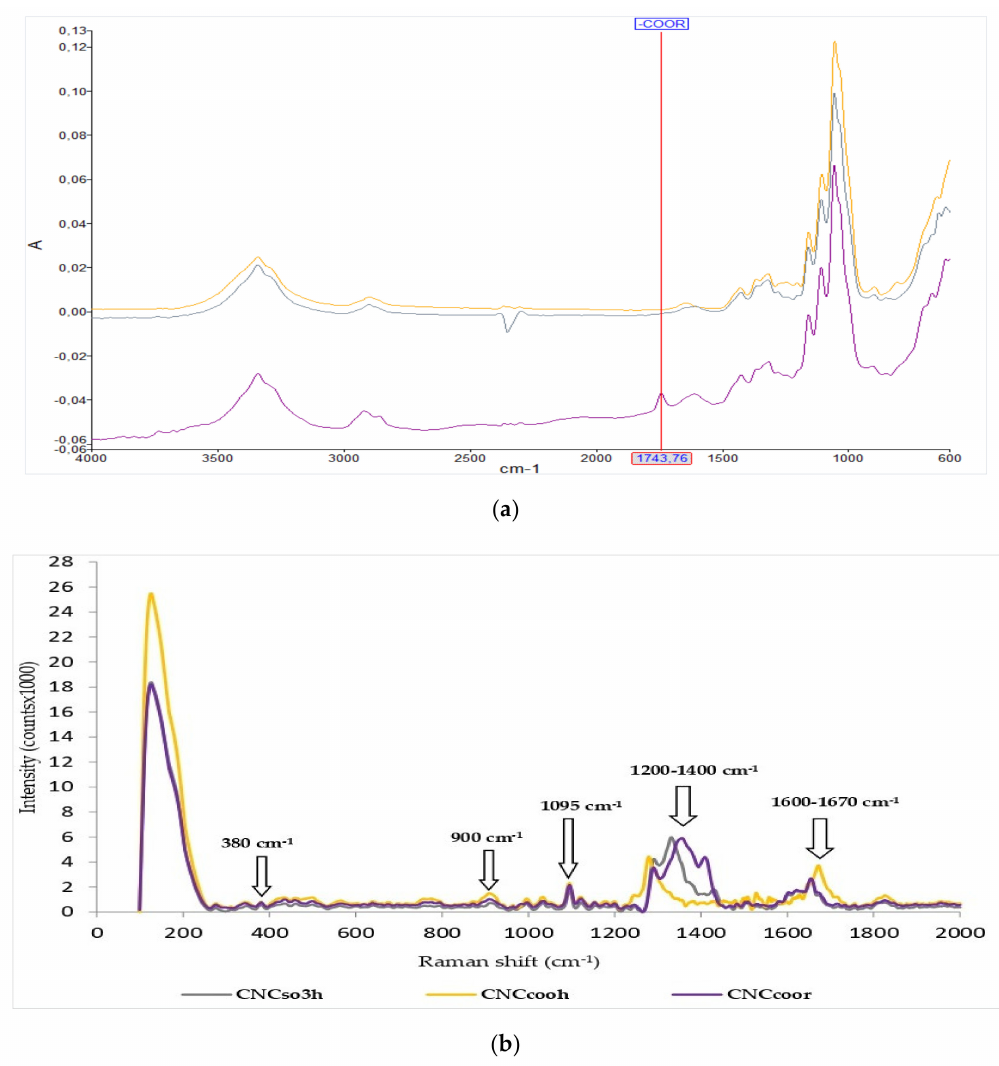
Figure 1. ( a ) Fourier-transform infrared spectroscopy (FTIR) spectra of the three types of cellulose nanocrystals (CNCs): CNC SO3H (yellow), CNC COOR (violet) and CNC COOH (green). ( b ) Raman analysis of the three CNCs productions: CNC SO3H (yellow), CNC COOH (green) and CNC COOR